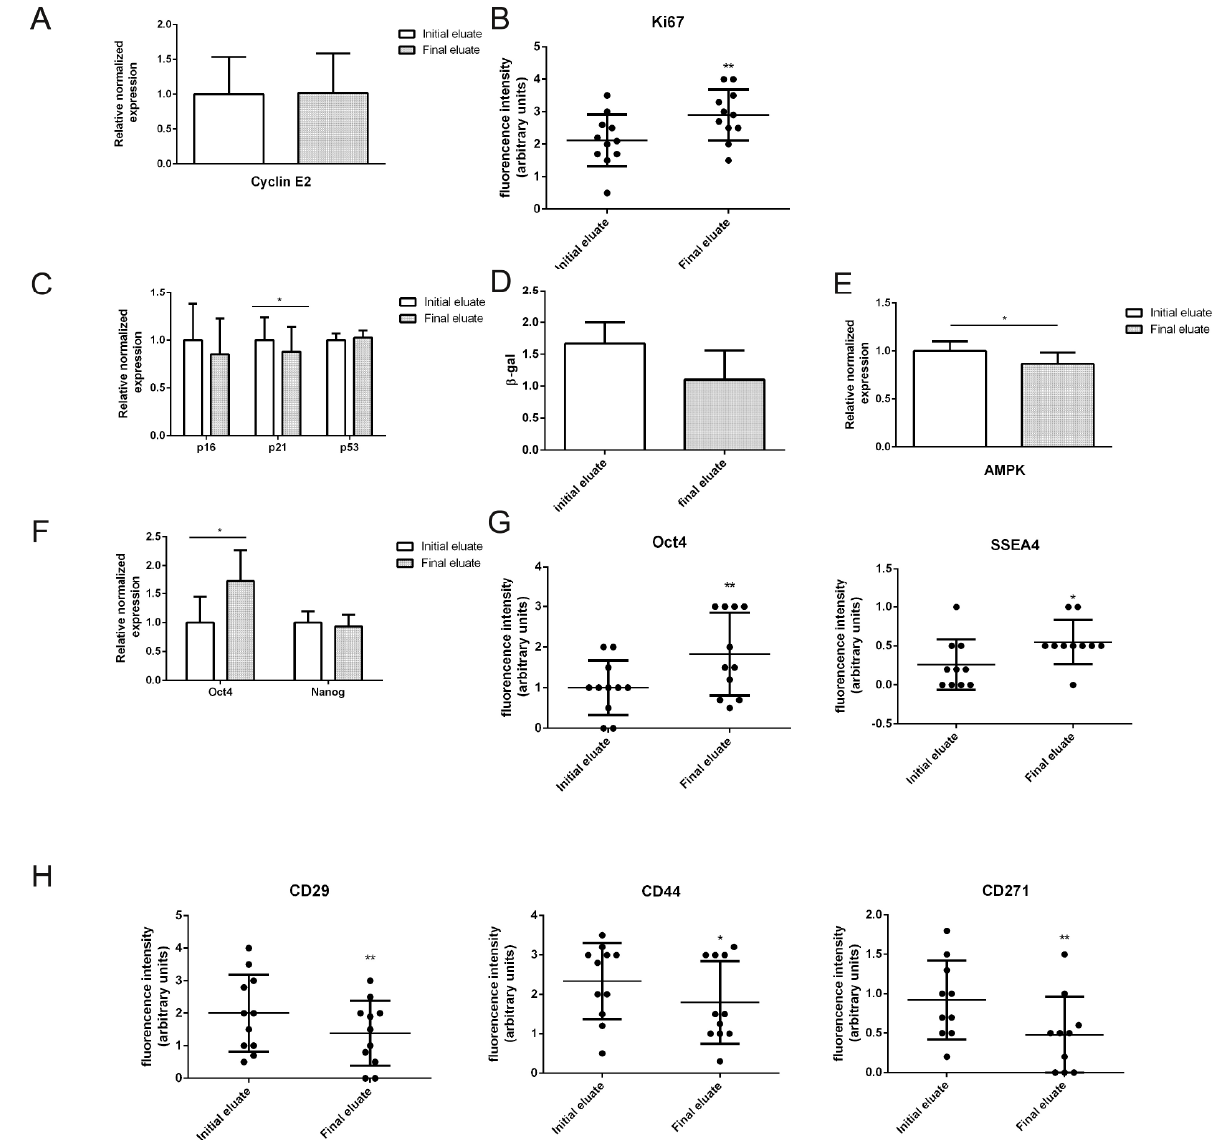
Figure 2. qPCR and immunofluorescence analysis of hAFSCs fractions. ( A , C , D , E , F ) Normalized expression of cyclin E2, p16, p21, p53, β -gal, AMPK, Oct4 and Nanog transcripts. Tubulin and GAPDH expression were used as housekeeping. Six different samples were analysed. ( B , G , H ) Distribution plots of fluorescence signal captured in confocal images (Figure S1) showing Ki67, Oct4, SSEA4, CD29, CD44, CD271. A paired test was applied. * p value < 0.05; ** p value <